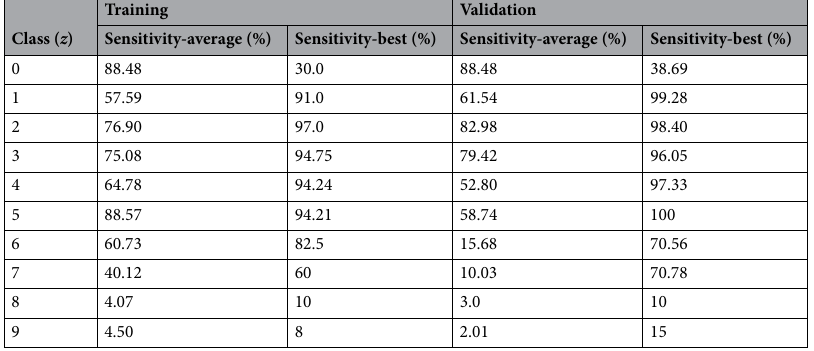
Table 6. Class sensitivity of the IsoDetecting module for fold 1, i.e., dilution sample 10, 11, 12 are used for training and 9 is used for validation. We show two cases, average and best case in terms of feature detection ability. The best case occurs when the feature is left aligned with the target window boundary, e.g., feature ‘A’ in Fig. 4a. The average case means the target window might contain any number of features, they may appear at any location of the window, they might be partially or fully seen and might be overlapping as well. Due to the lack of variance in training data for charge states 6–9, the model’s validation sensitivity does not go up high for these classes. However, since most of the peptide features appear with charge states < 6, lower sensitivity for them does not impact the overall performance. The validation set does not contain any duplicated data and there is no overlapping between validation samples and training samples.